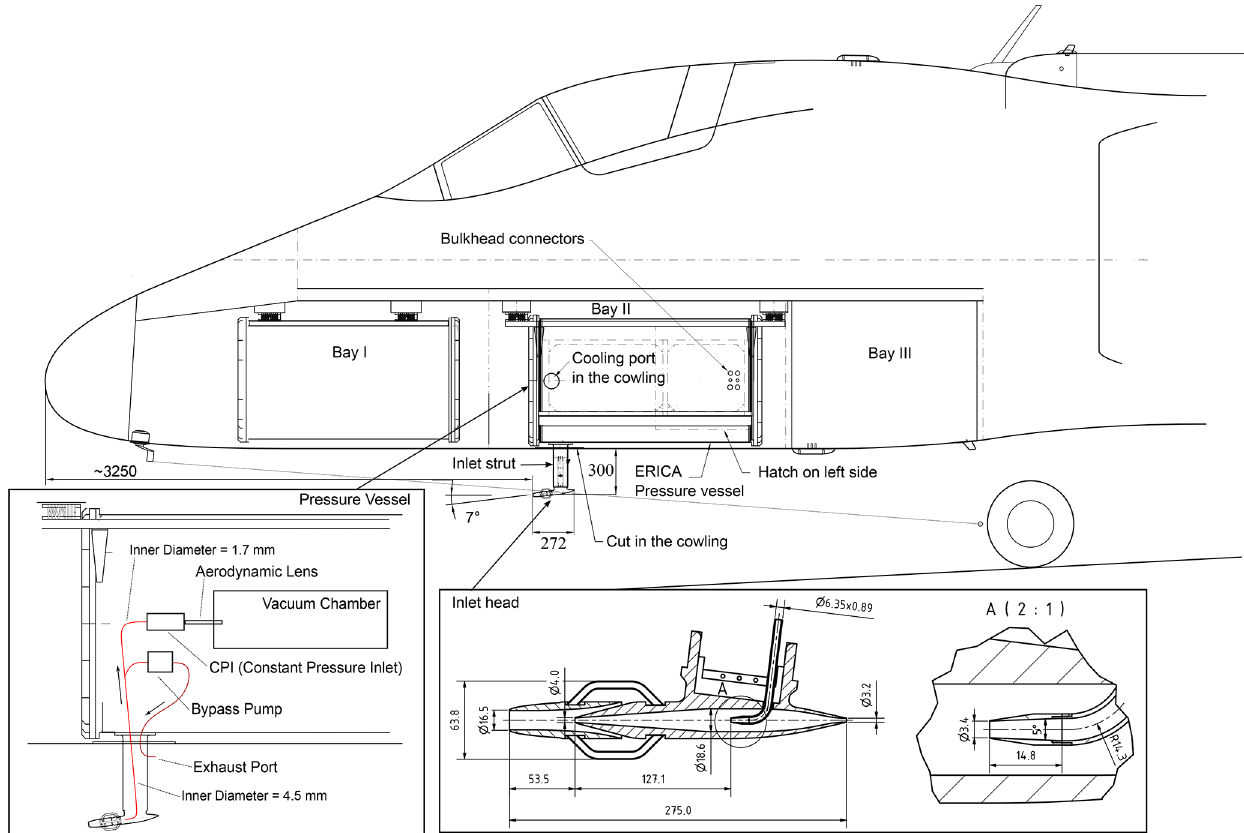
Figure 2. Top: drawing of the aircraft with the ERICA installed. Bottom left: a close-up of the pressure vessel showing the inlet sampling and bypass lines. Bottom right: a cross-section of the ERICA inlet head. All dimensions are in